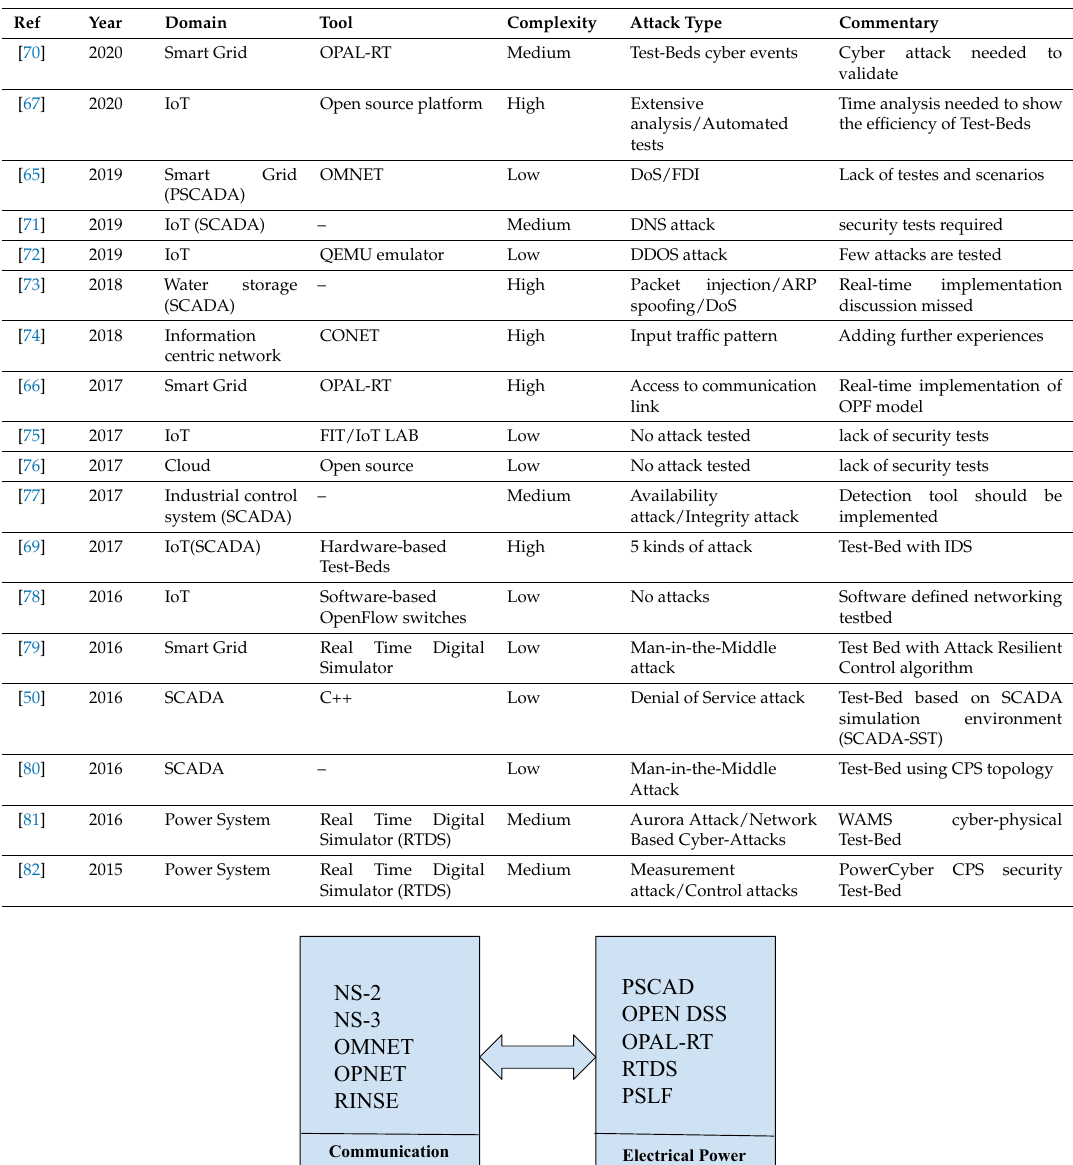
Table 4. Some Cyber-Attacks and their Domain in the last 5 years.